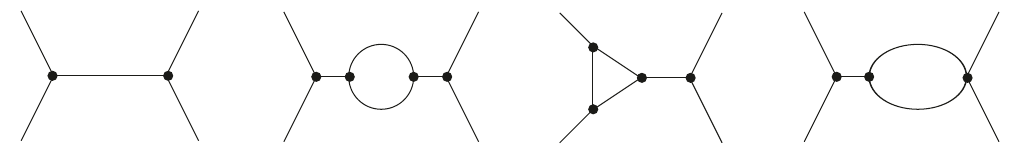
Figure 15 . The figure represents the geometries obtained via combining the third derivative of Γ[ A ] via a propagator or bubble diagram. For simplicity we suppress the symmetry factors, sign etc. c bubble diagram. These are shown in figure 15. These diagrams exhaust the set of possible geometries contributing to a four point amplitude up to